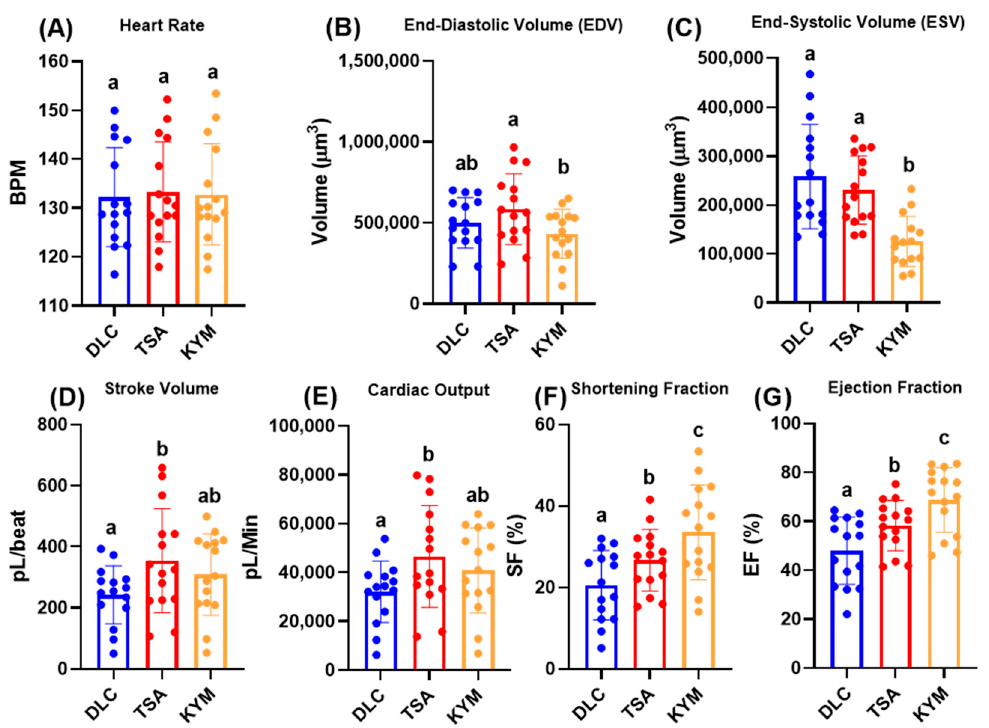
Figure 4. Cardiac physiology parameter comparison between DLC, ImageJ TSA, and Kymograph methods in zebrafish. Results for heart rate ( A ), end-diastolic volume ( B ), end-systolic volume ( C ), normalized stroke volume ( D ), cardiac output ( E ), shortening fraction ( F ), and ejection fraction ( G ), from three methods were compared statistically by RM one-way ANOVA followed by Tukey’s multiple comparisons test. Data are expressed as mean ± SD and significant differences ( p < 0.05) are indicated by lower case a, b, and c ( n = 15).